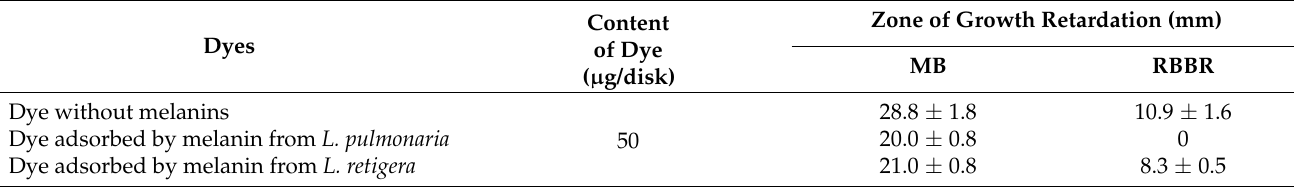
Table 5. Effects of melanins on the bacterial growth retardation caused by MB and